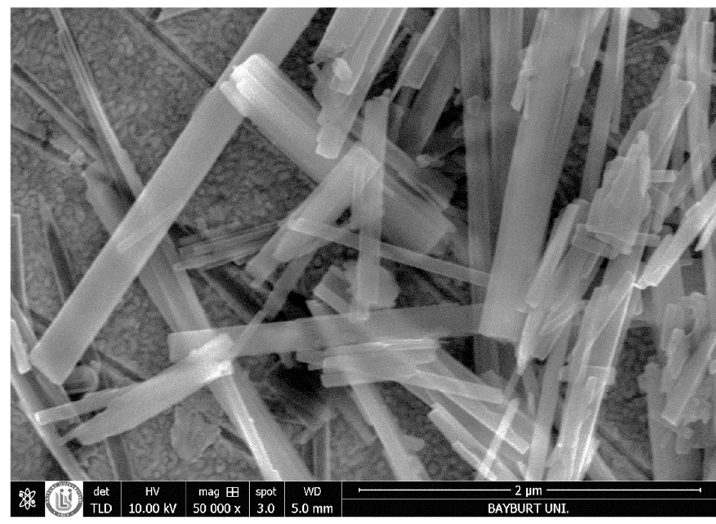
Figure 3. SEM image of TiO 2 -NTs.